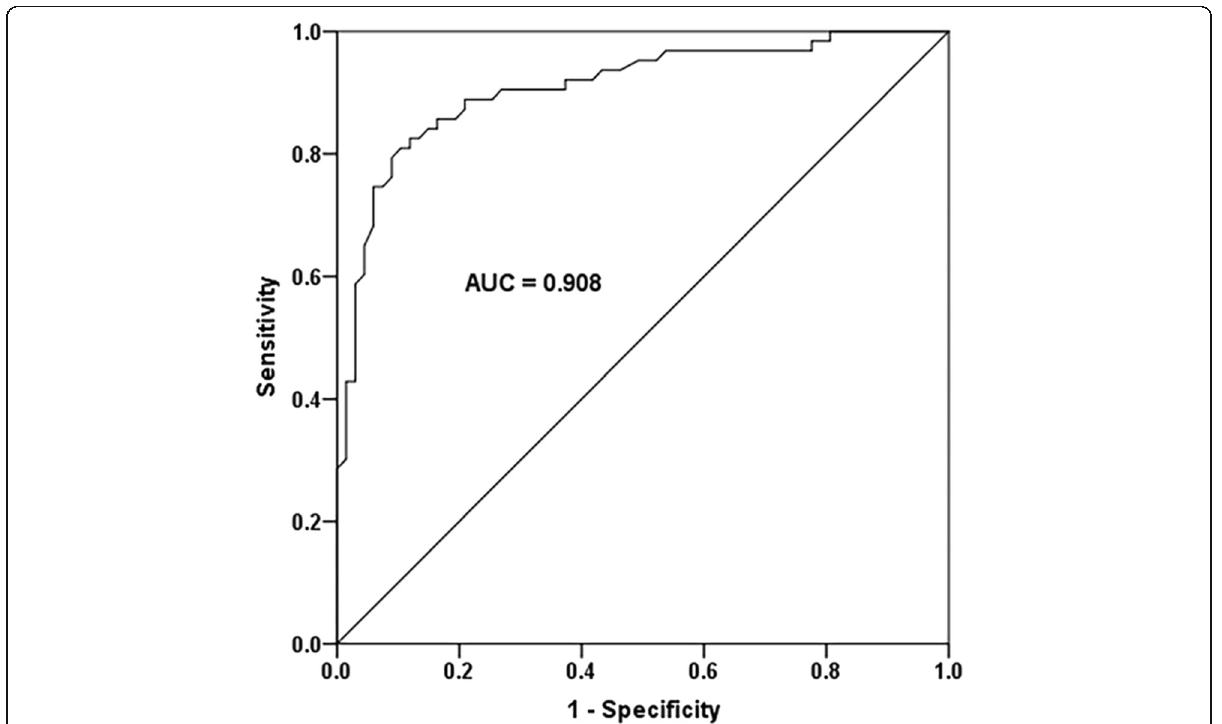
Fig. 2 A receiver operating characteristic ROC curve was conducted to calculate the diagnostic value of serum miR-15a-5p for TLE. The area under the curve (AUC) for miR-15a-5p was 0.908, with a sensitivity of 82.5% and specificity of 88.1% at the cutoff value of